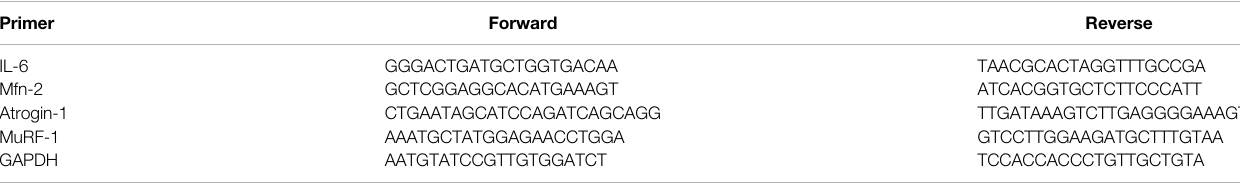
TABLE 1 | Primer sequences in this